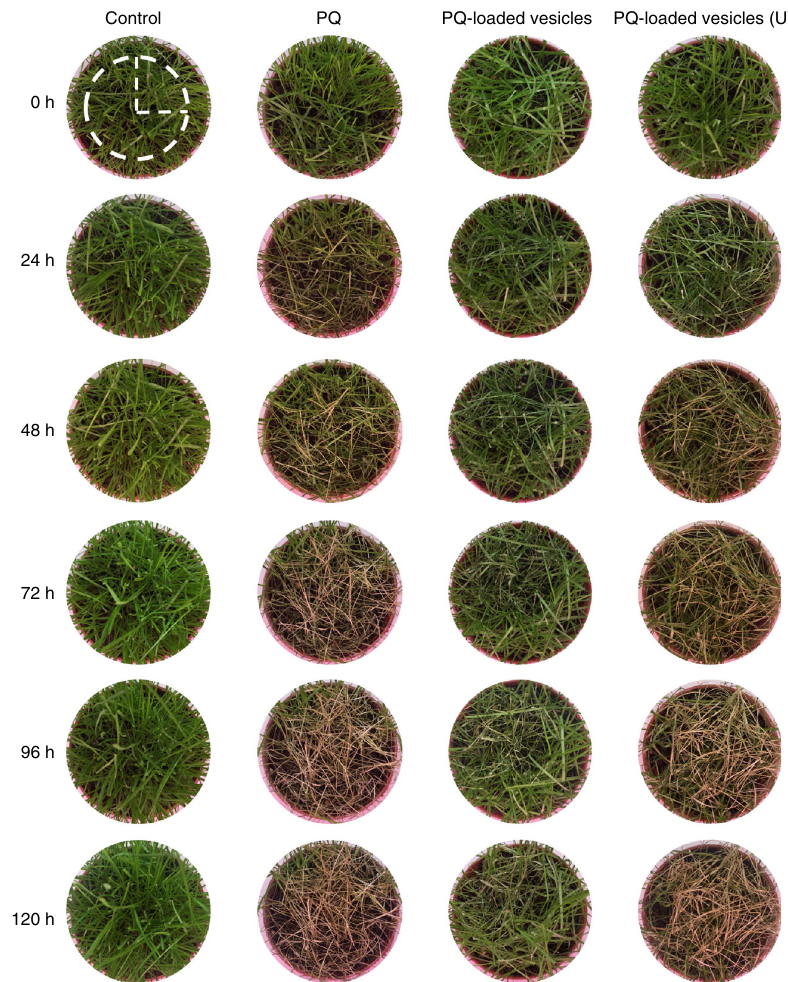
Fig. 6 Weed control ef fi cacy of free PQ and PQ-loaded photo-responsive vesicles. Foliar application of control (water), PQ and PQ-loaded vesicles under irradiation of simulated sunlight, and PQ-loaded vesicles under irradiation of simulated sunlight without UV light, at a single dose of 2 mg mL − 1 . Diameter of the white-dashed circle: 6